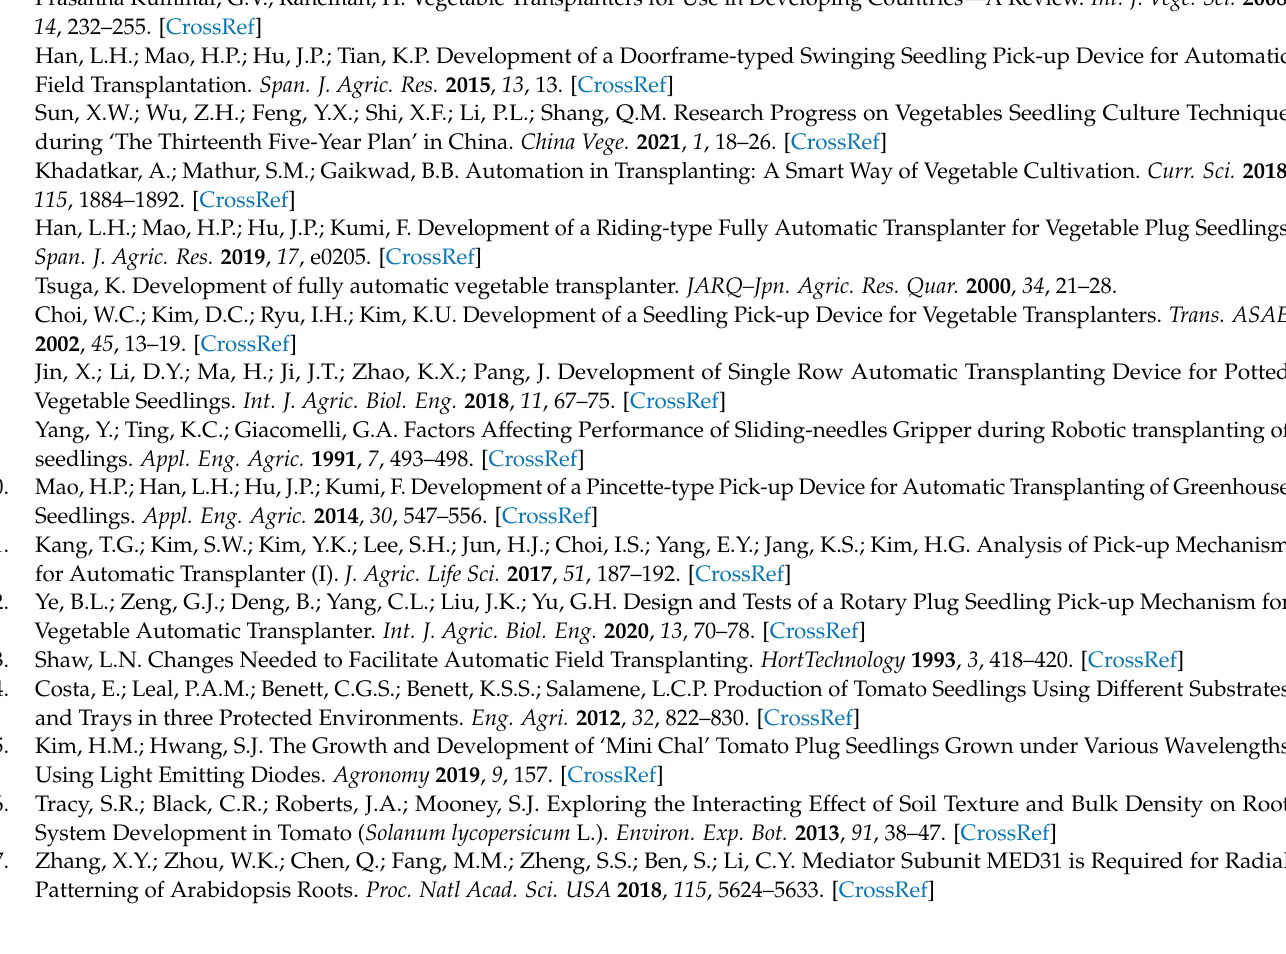
Figure S4: Testing for the growth and mechanical properties of plug seedlings, Figure S5: Automatic transplanting works from the growing trays to the destination